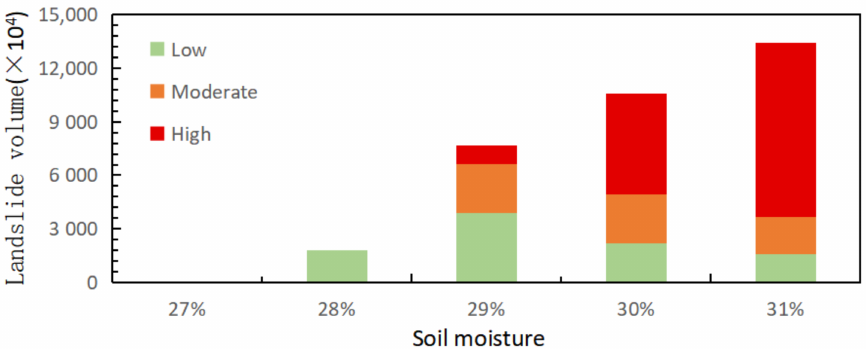
Figure 14. Landslide volume with different soil water content.